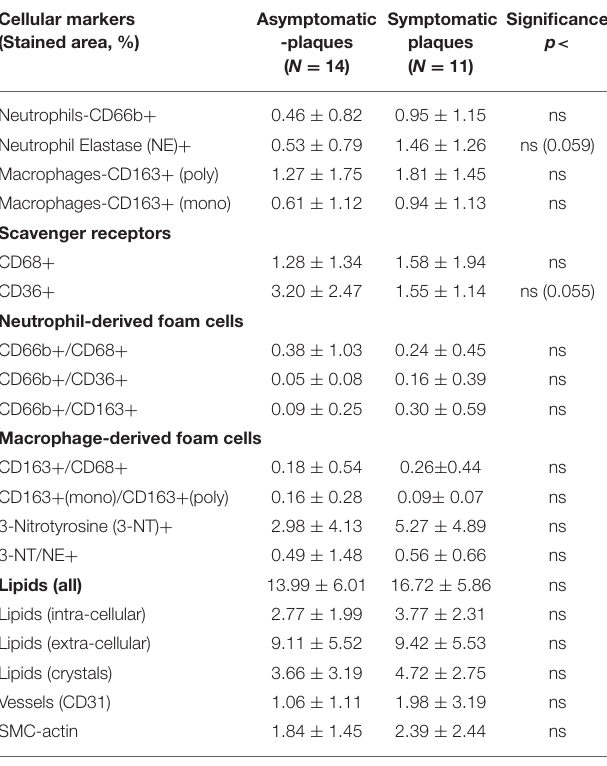
TABLE 4 | Quantitative analysis of cellular plaque markers (by % stained area ± SD) in asymptomatic and symptomatic patients. Cellular markers (Stained area, %)